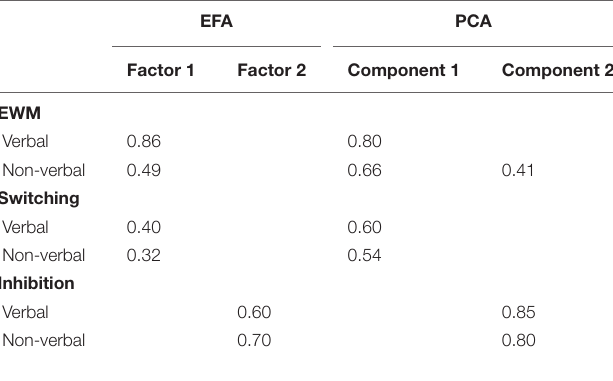
TABLE 3 | Pattern matrix for exploratory factor analyses (EFA; oblique rotation) and principal components analyses (PCA; varimax) on assessments of EWM, switching, and